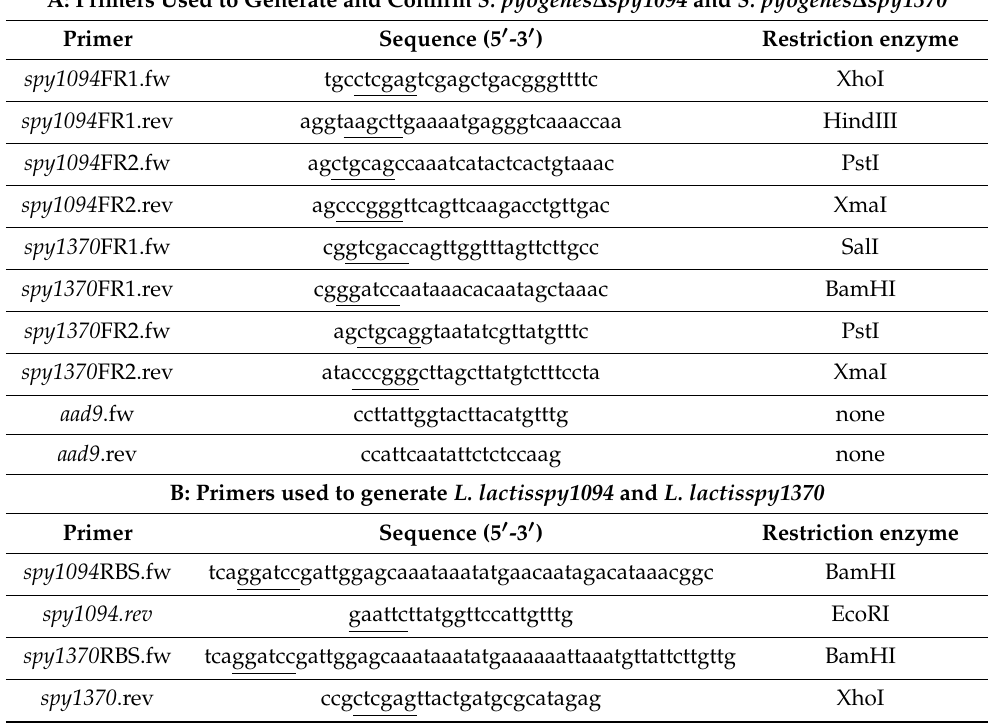
Table 1. Primers used in this study. The restriction enzyme sites are underlined. A: Primers Used to Generate and Confirm S. pyogenes ∆ spy1094 and S. pyogenes ∆